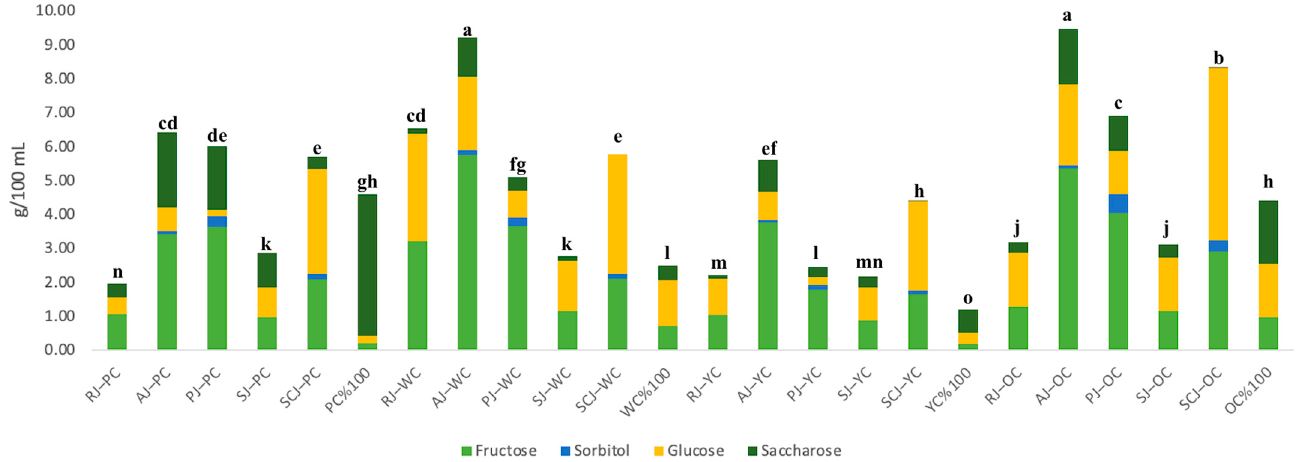
Figure 2. The total sugars (g/100 mL) in carrot-blended smoothies, letters above columns indicate statistical significance at p ≤ 0.05 according to Tukey’s test (the same letter = not significantly different). Total sugar content: RJ–PC, 1.97n. AJ–PC, 6.41cd. PJ–PC, 6.00de. SJ–PC, 2.87k. SCJ–PC,